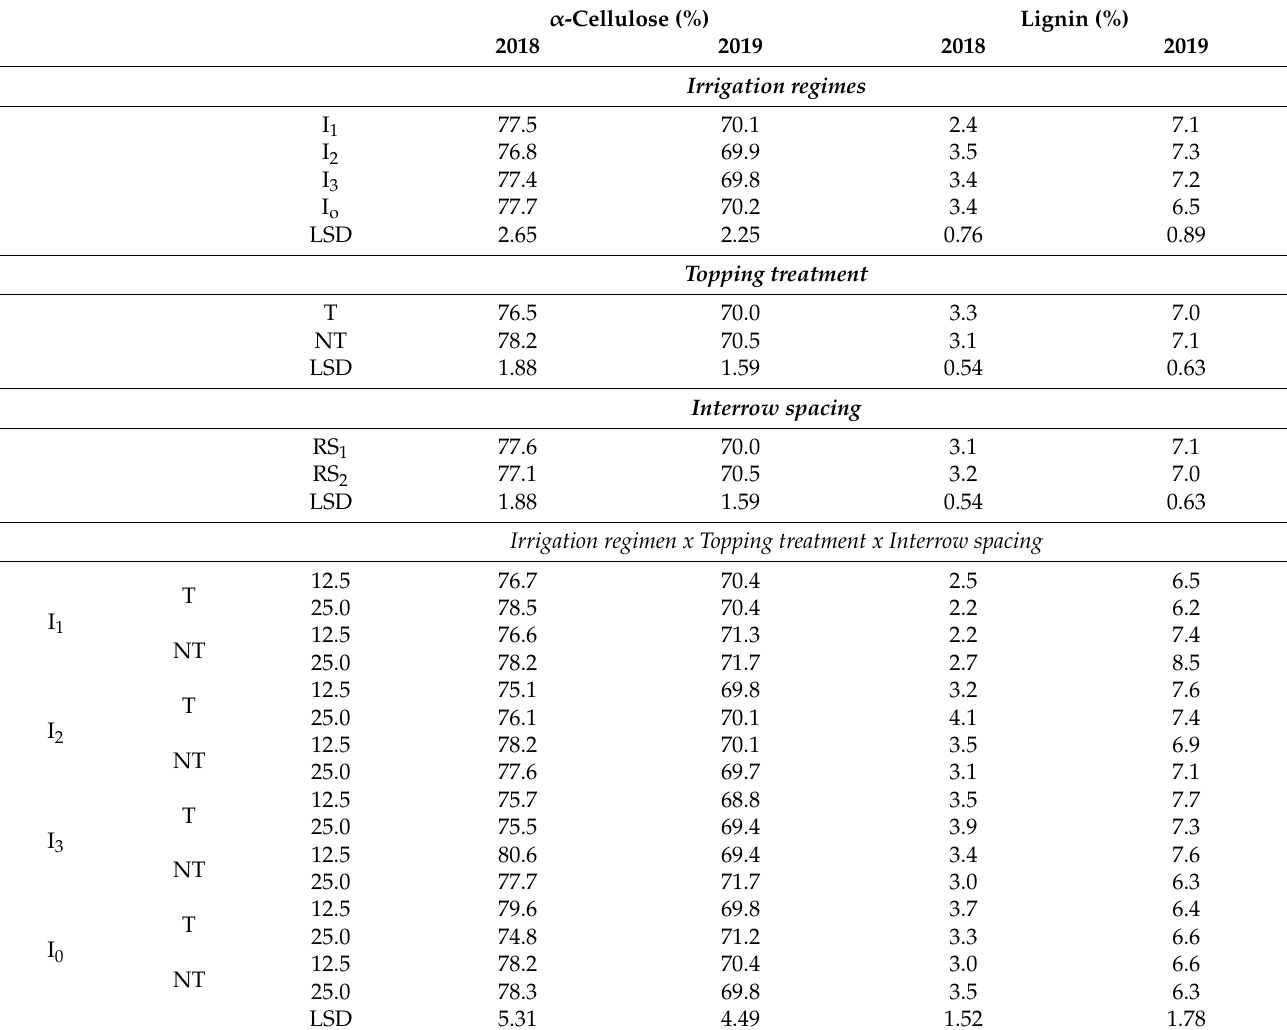
Table 6. Irrigation, topping, and row spacing effects on the quality of hemp fibers. α -Cellulose